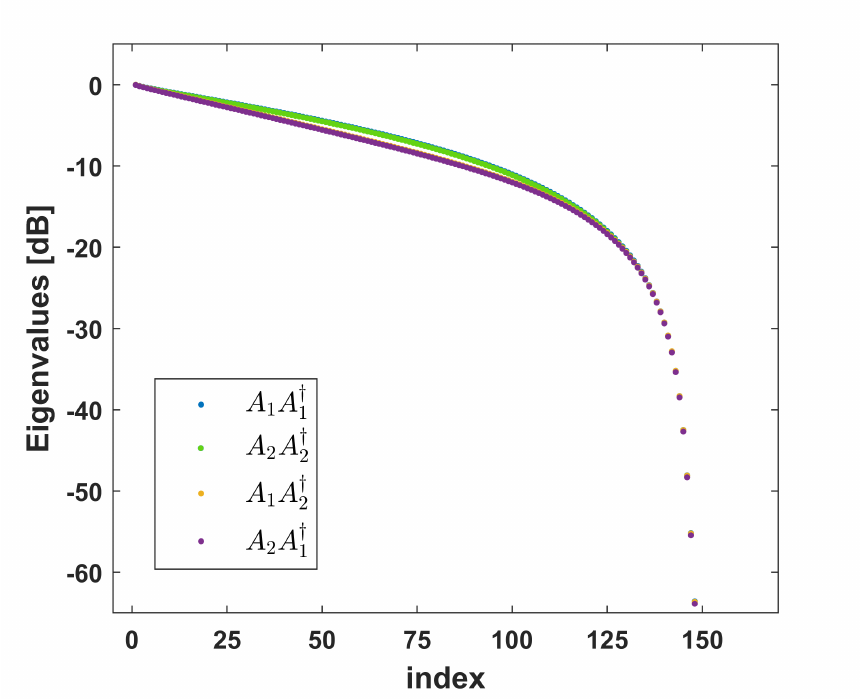
Figure 6. Eigenvalues of the operators A 1 A † z 2 = 5.25 λ , X 1 = 20.75 λ ( η ( X 1 , z 1 ) = 0.9 ) , X 2 = 21.01 λ ( η ( X 2 , z 2 ) = 0.9 )